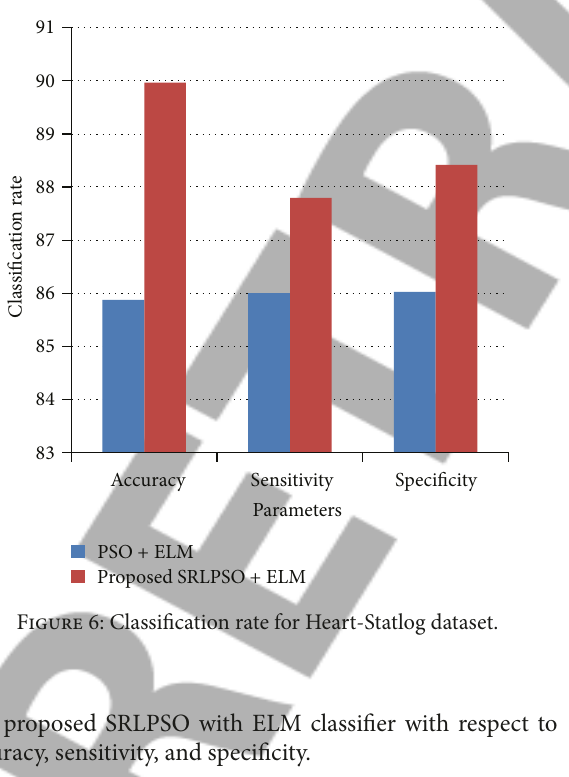
Figure 6: Classification rate for Heart-Statlog dataset.